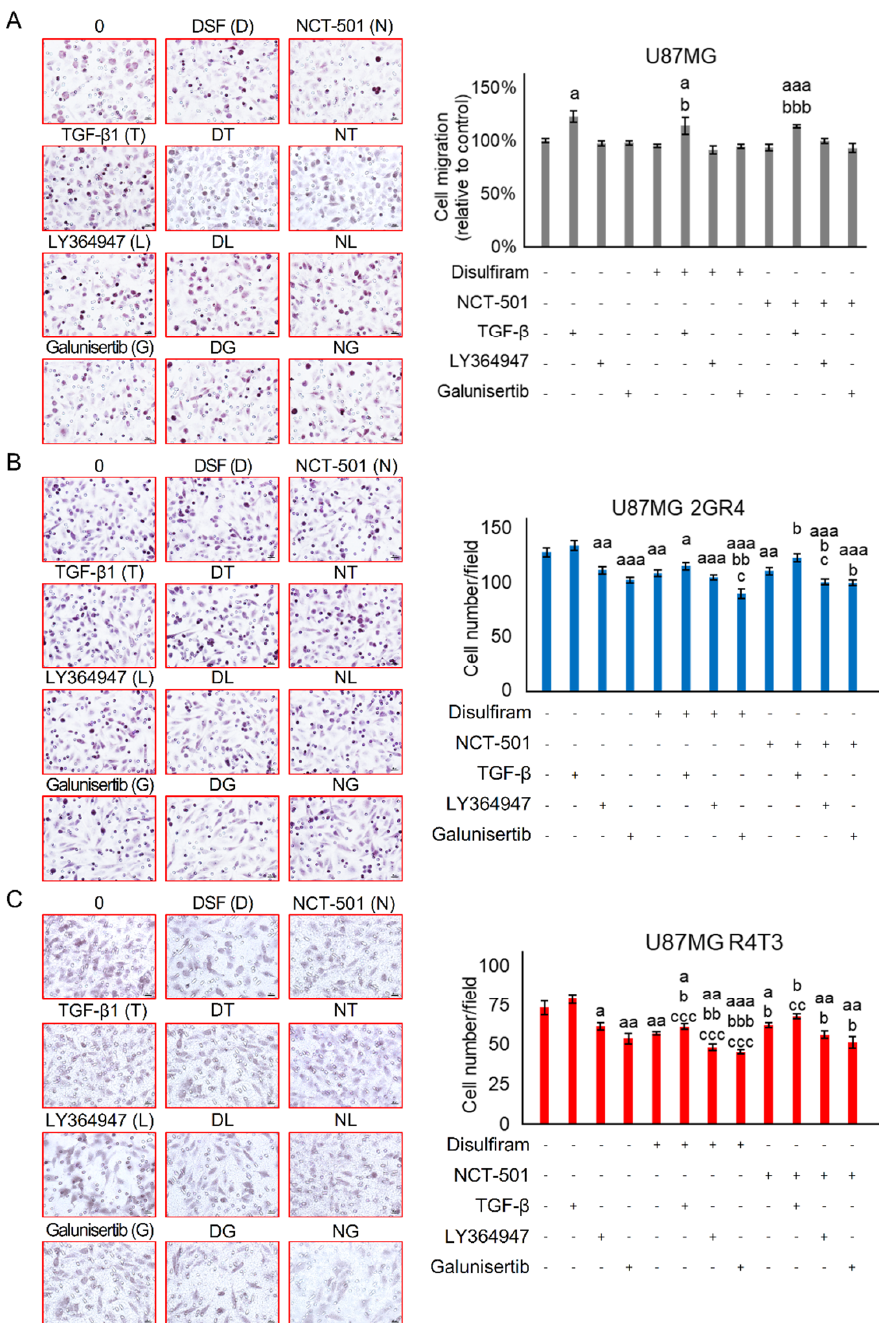
Figure 5. Combining ALDH and TGF-β inhibition suppresses the cell mobility. The cell mobility was evaluated using a 3D Transwell assay. 150 nM DSF, 100 nM NCT-501, 10 ng/mL TGF-β, 4 μM LY364947, and 100 μM Galunisertib were selected to treat the cells for 9 h. The “ + ” means with the treatment while the “ - ” means without the treatment. ( A ) Graphs showing the migratory cells and histogram indicating the cell mobility of U87MG under the various treatments; N = 6; ( B ) graphs showing the migratory cells and histogram indicating the cell mobility of radiation-resistant U87MG 2GR4 under the various treatments; N = 6; ( C ) graphs showing the migratory cells and histogram indicating the cell mobility of radiation-TMZ-resistant U87MG R4T3 under the various treatments; N = 6; scale bar = 20 μm; mean ± SEM; a refers to a comparison with the control; b refers to a comparison with sole DSF or NCT-501; c refers to a comparison with sole TGF-β1 or LY364947 or Galunisertib; a, b, c, p < 0.05; aa, bb, cc, p < 0.01; aaa, bbb, ccc, p < 0.001.